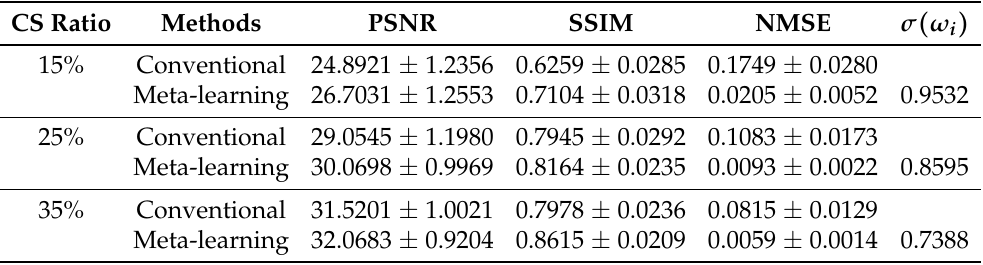
Table 4. Quantitative evaluations of the reconstructions of T2 brain image associated with various sampling ratios of radial masks. Meta-learning was trained with CS ratios of 10%, 20%, 30%, and 40% and tested with unseen ratios of 15%, 25%, and 35%. Conventional method was subjected to regular training and testing with the same CS ratios of 15%, 25%, and 35%.